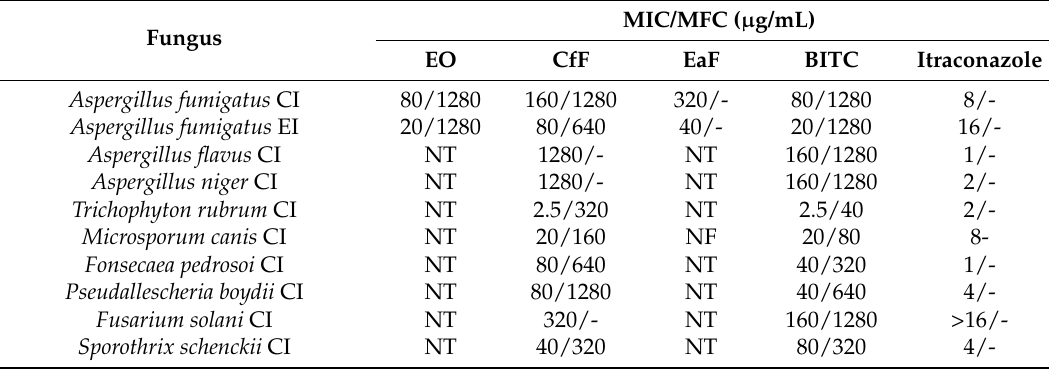
Table 3. Antifungal activity of the essential oil and fractions from the CE of T. pentaphyllum tubers, against dermatophytes and filamentous